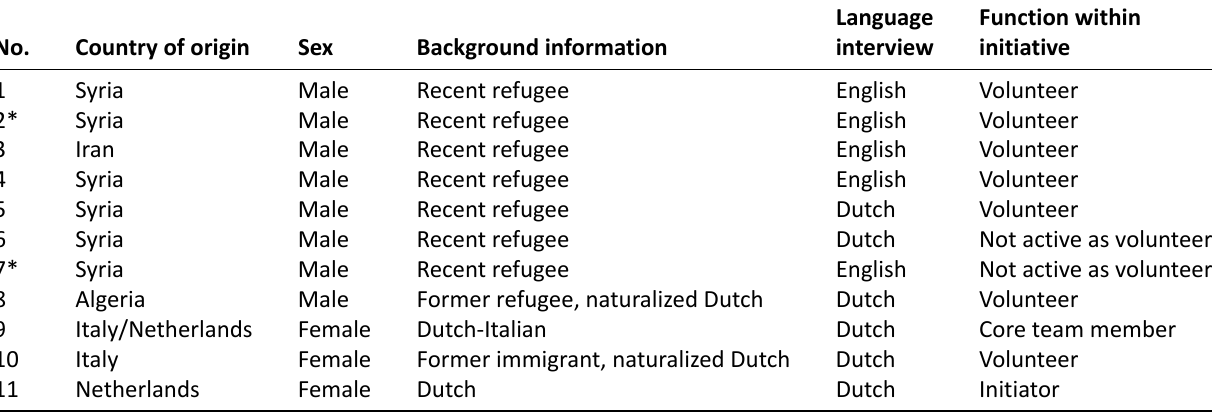
Table 1. Characteristics of